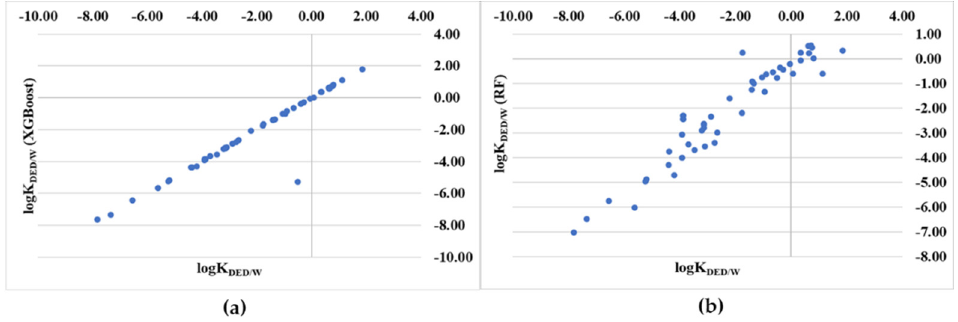
Figure 4. Correlation between ( a ) XGBoost computed and ( b ) random forest computed partition coefficients (logKDED/W) with the experimental results. Table 4. Performance metrices of the machine learning model in the quantitative predictions of logK DED/W .